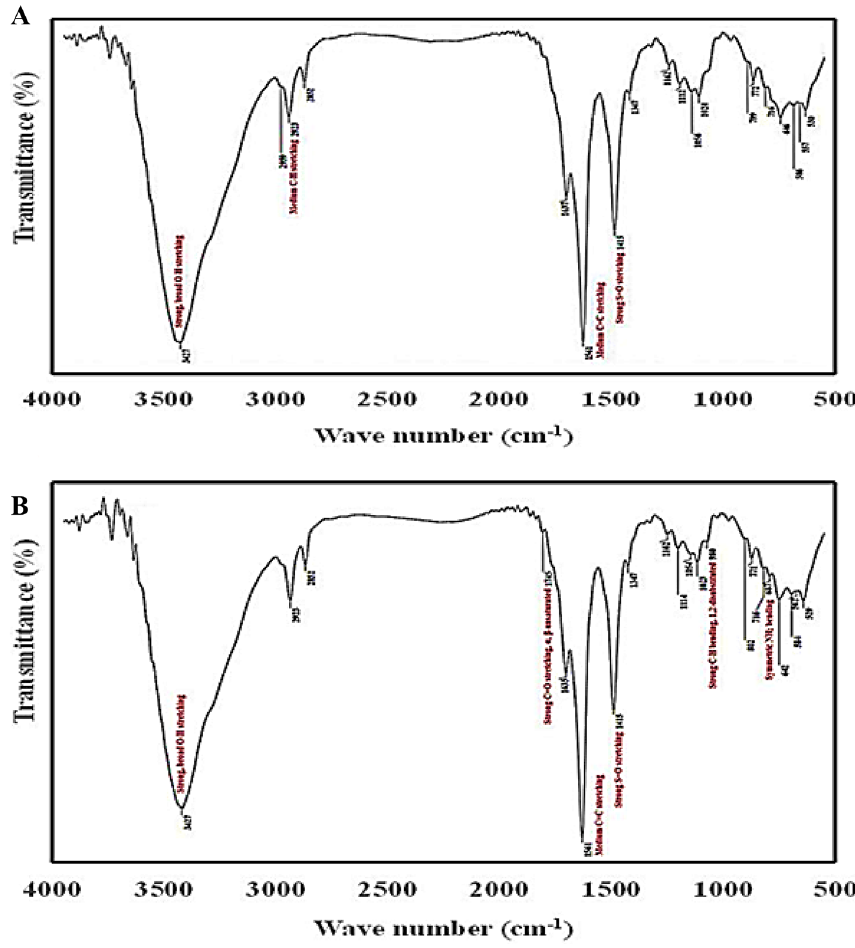
Figure 8. P. alcaliphila NEWG-2 spectral charts of the FTIR analysis of control ( A ), and treated with methylene blue dye ( B